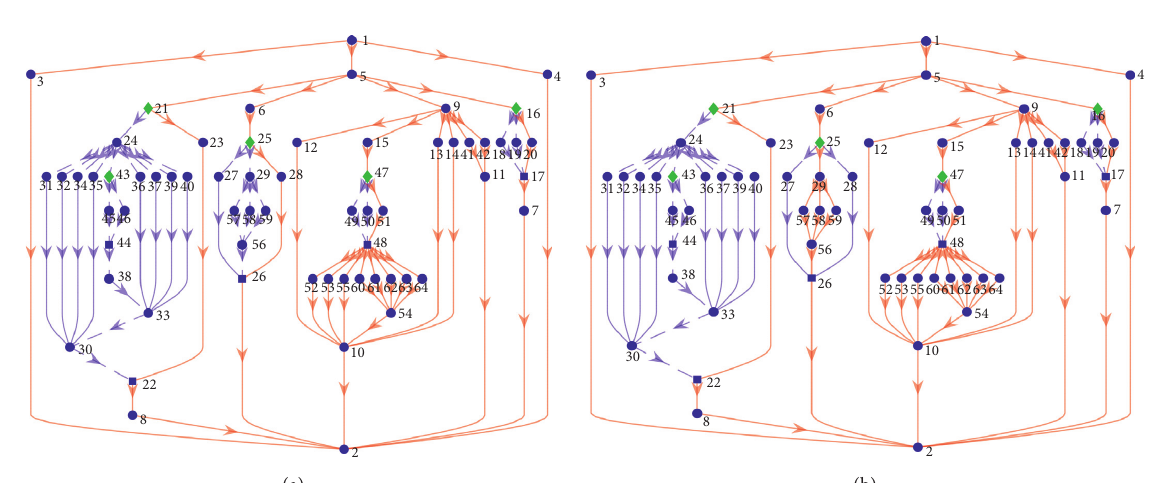
Figure 9: The shortest path of the AND/OR network with 64 nodes and 98 edges: (a) integer-programming model optimization results and (b) precursor-based “OR” node cut-off